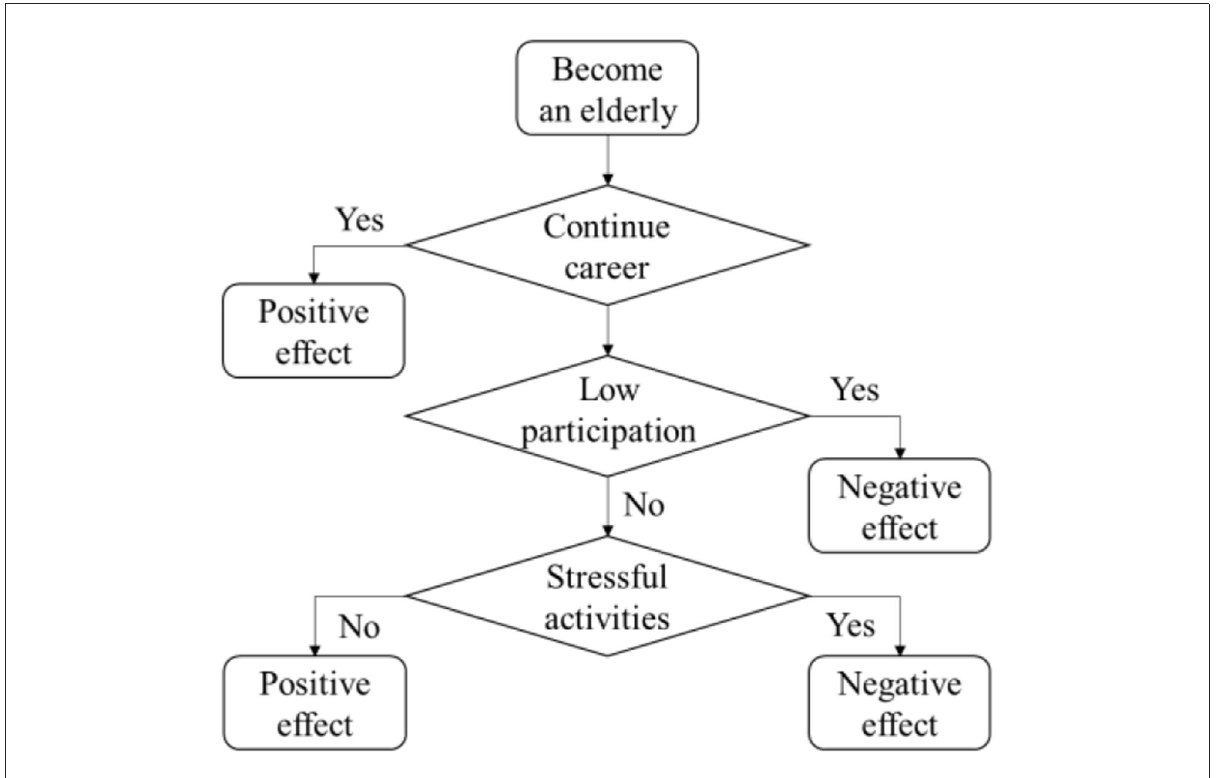
FIGURE5 The effect of social participation on the memory of the